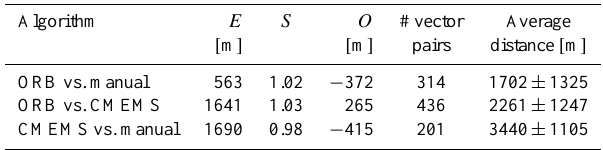
Table 4. Comparison of ORB, CMEMS and manually derived sea ice drift data from image pair Fram Strait (Table 1). The total num- bers of derived vectors are 6920 (ORB), 560 (CMEMS/DTU) and 350 (manual). The # vector pairs is the number of used vector pairs for comparison, i.e. vector pairs with maximum 5km distance. The average distance refers to the starting locations of the used reference and validation vectors. E is the root mean square error, S and O are slope and offset of the linear